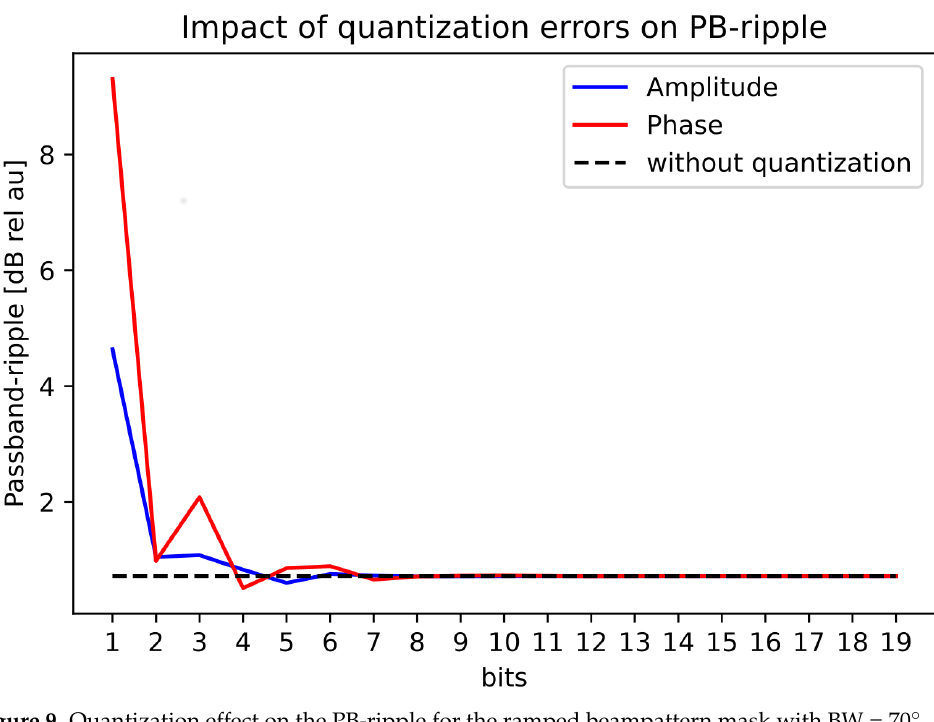
Figure 9. Quantization effect on the PB-ripple for the ramped beampattern mask with BW = 70 ◦ .